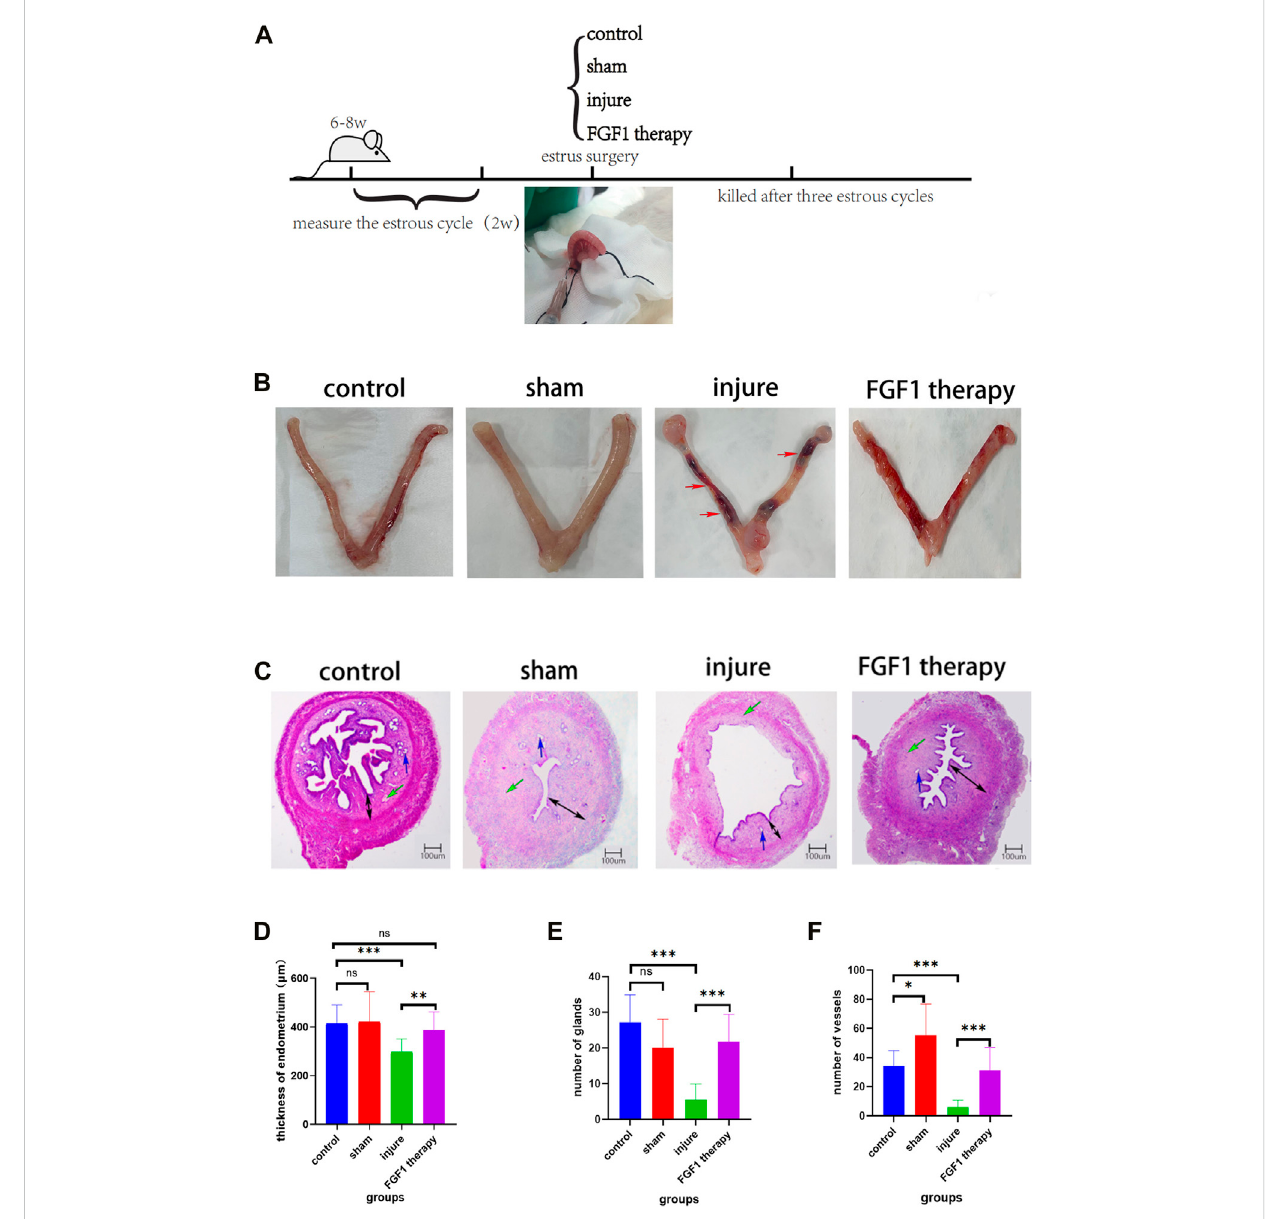
FIGURE 1 Morphological and histological structure of endometrium. Thin endometrial construction and experimental groups (A) ; The morphology of the uterus in different groups. The red arrow points to the area of uterine stenosis and bruising following ethanol injury (B) ; Histological features of the endometrium after HE staining. The blue arrow points to the endometrial glands. The green arrow points to endothelial vessels. The black arrow represents the thickness of the endometrium. HE, 40X (C) ; Changes in endothelial thickness between groups. n = 10, ns > 0.05, ** p < 0.01, *** p < 0.001 (D) ;Changesinthenumberofendometrialglandsbetweengroups.n=8,ns > 0.05,*** p < 0.001 (E) ;Changesinthenumberofendometrialvessels between groups. n = 10, * p < 0.05, *** p < 0.001 (F)